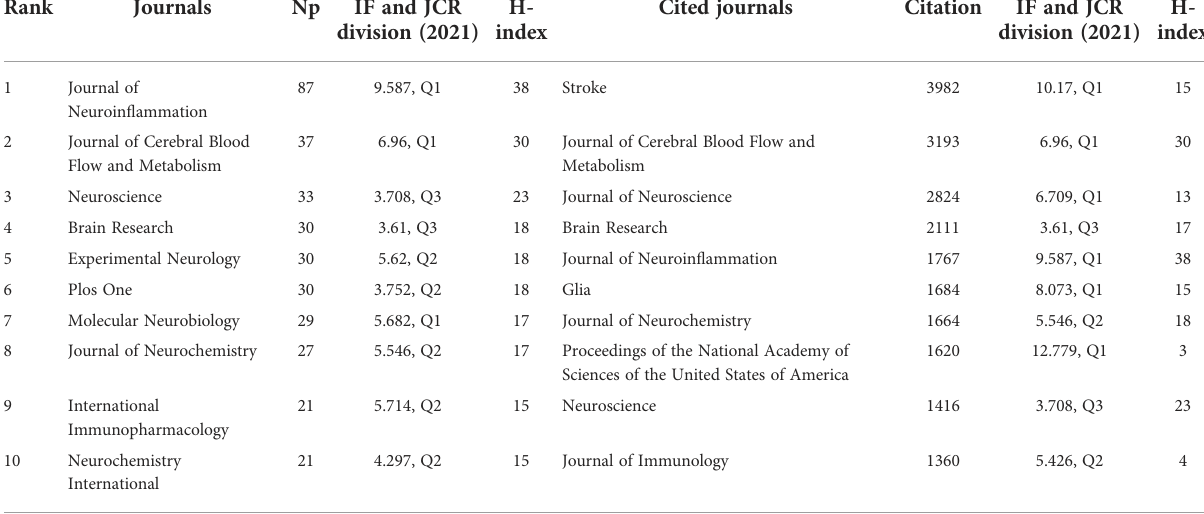
TABLE 4 The top 10 most productive journals and cited journals. Rank